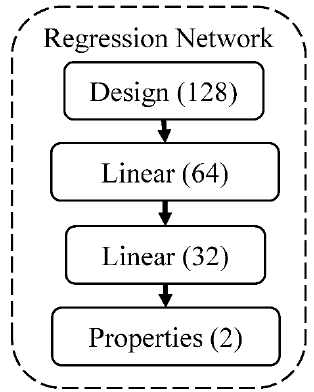
Figure 6. The neural network ’ s architecture for predicting the mechanical properties of composite material. The numbers in the parentheses are the hidden units.